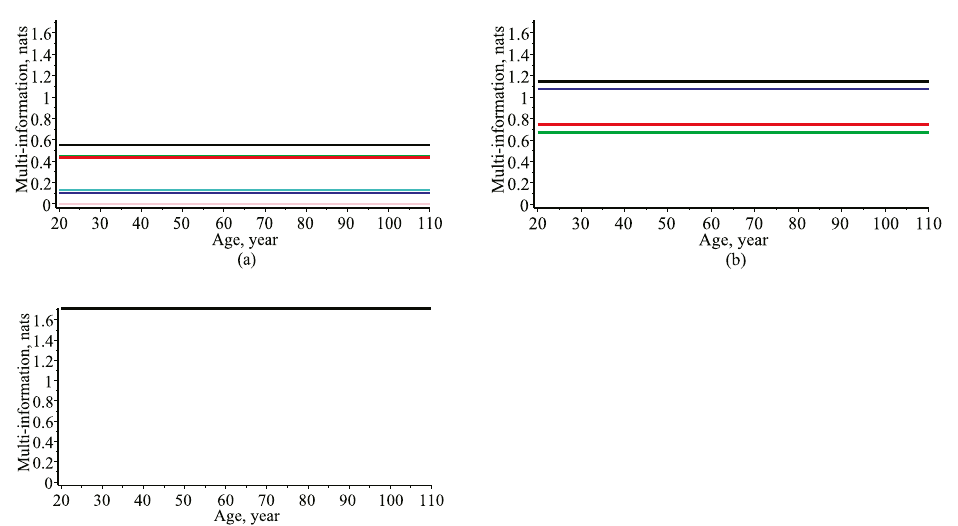
Figure 3. Evolution of multi-information. ( a ) Bivariate; black—diameter and height; blue—diameter and crown base height; green—diameter and crown width; red—height and crown base height; cyan—height and crown width; pink—crown base height and crown width. ( b ) Trivariate; black—diameter, height and crown base height; blue—diameter, height and crown width; green—diameter, crown base height and crown width; red—height, crown base height and crown width. ( c ) 4-variate, diameter, height, crown base height and crown width.